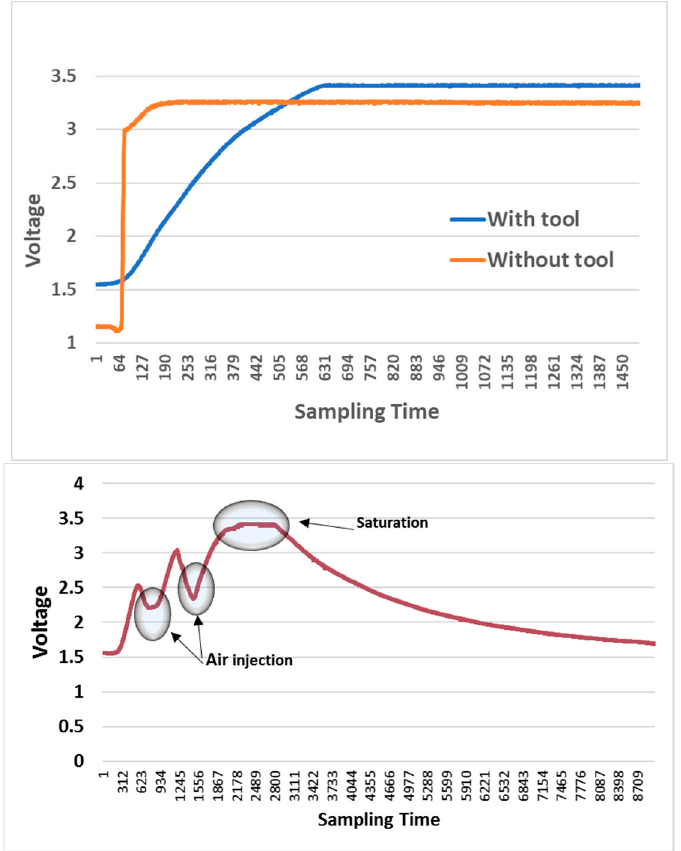
Figure 4. Measurements with and without Venturi tool ( top ). Airflow test using an injection pump ( bottom ). The sampling time is measured in tenths of a seconds.